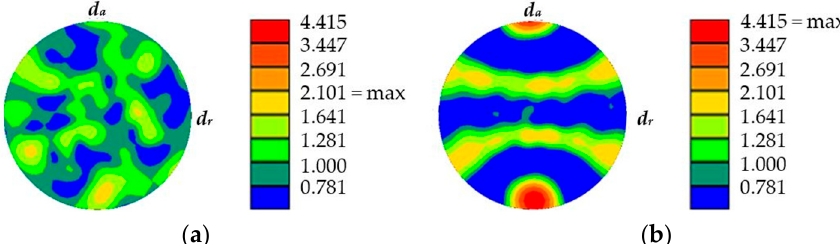
Figure 4. Electron backscatter diffraction (EBSD) texture plot of the longitudinal cross-sections in the flow direction for the material states ( a ) as-received (AR) and ( b ) after extrusion (E.530/E.590) with radial direction d r and axial direction d a . The maximum value of the texture indicated for the different material states is indicated with max .